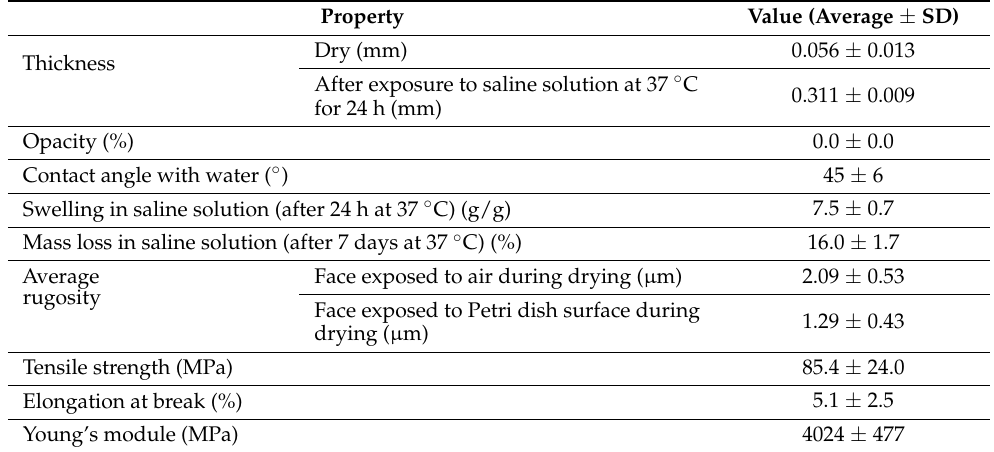
Table 1. Properties of the CA membranes plasticized with glycerol used in the in vivo